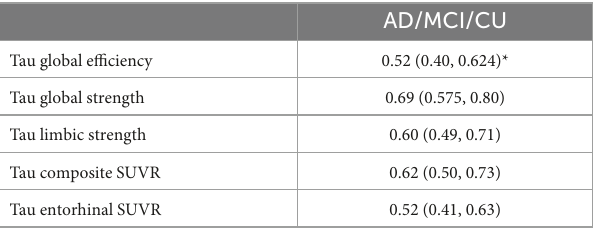
TABLE 2 Effect sizes, Cohen’s f , from either FTP PET network measures or regional measure volumes for the for ancova of the three groups (AD, MCI,